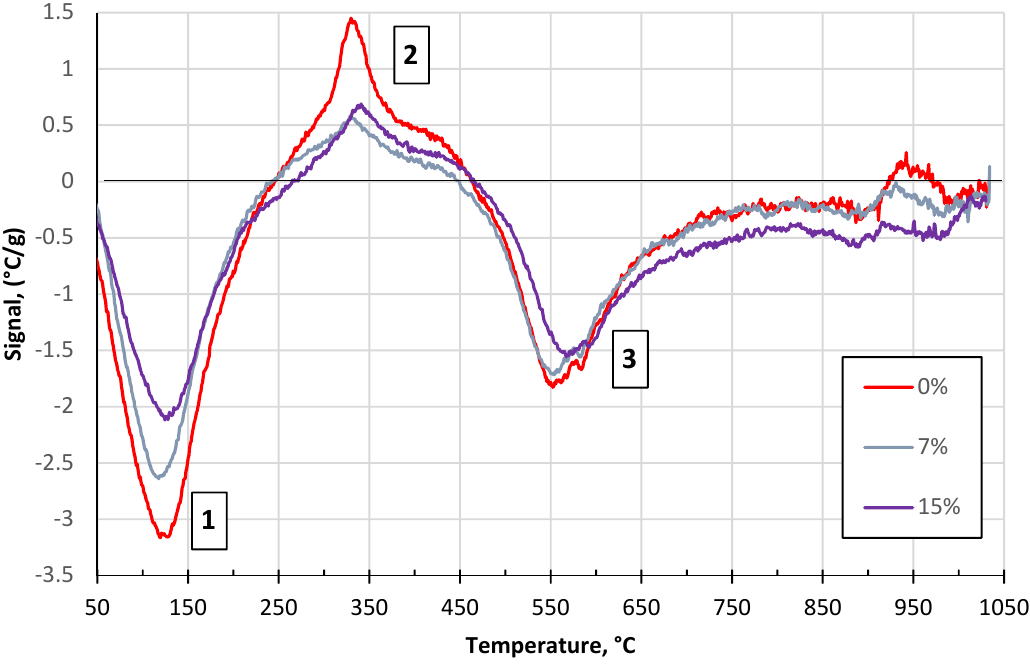
Figure 4. Dilatometric curves of the tested clay-glass ceramic materials in temperature range from 20 up to 1300 °C. Detected events are indicated. The content of glass in wt% is in the legend. The addition of any amount (5–15 wt%) of GC decreased the onset of the clay’s sintering from 900 °C down to 860 °C. The course of the dilatometric curves did not differ significantly for the prepared samples (linear expansion up to the onset of the sintering, then shrinkage). Thus, the sintering was mainly governed by the clay in the samples. Once melted, the glass filled the pores in the ceramic body, thus leading to a more pronounced densification. This behavior highlights the role of the glass in the sample.